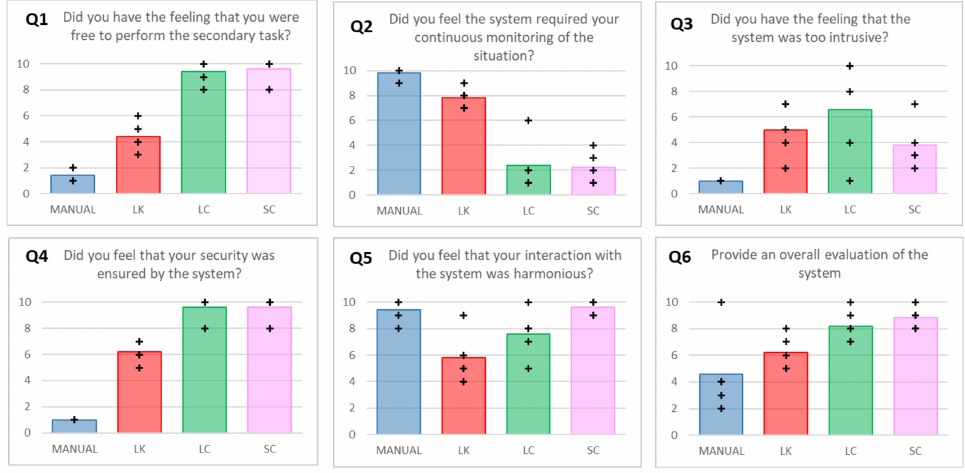
Figure 15. System performance perception from questionnaires applied to the test